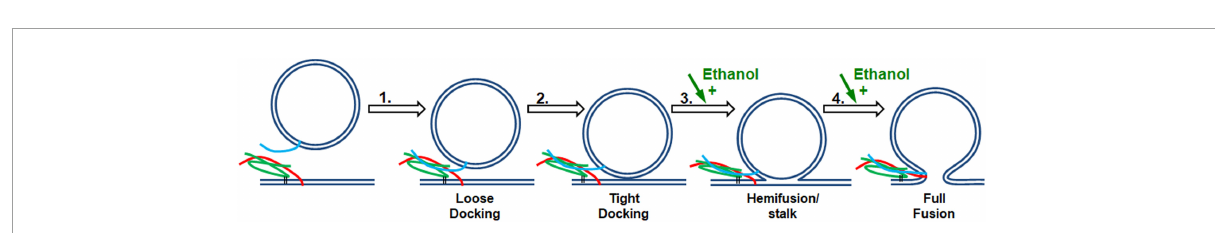
FIGURE7 SNARE vesicle fusion process. (1) SNARE assembly leads to Loose Docking. (2) Generation of protein-free membrane patch, overcoming electrostatic repulsion, and dehydration leads to Tight Docking. (3) Lipid tail splaying leads to Hemifusion/stalk formation. (4) Fusion of distal membrane leaflets (pore formation) leads to Full Fusion. Our data suggest that ethanol is acting at transition 3 and/or transition 4. Individual components shown are as in Figure 1 .